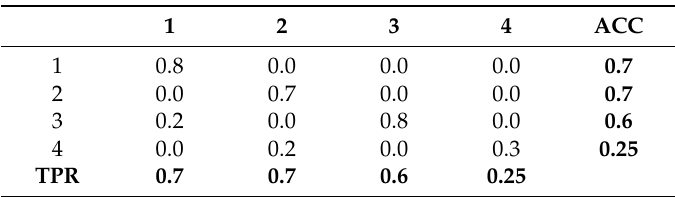
Table 8. Confusion matrix for different session numbers (S1–S4). Column headers represent predicted values and row headers represent actual